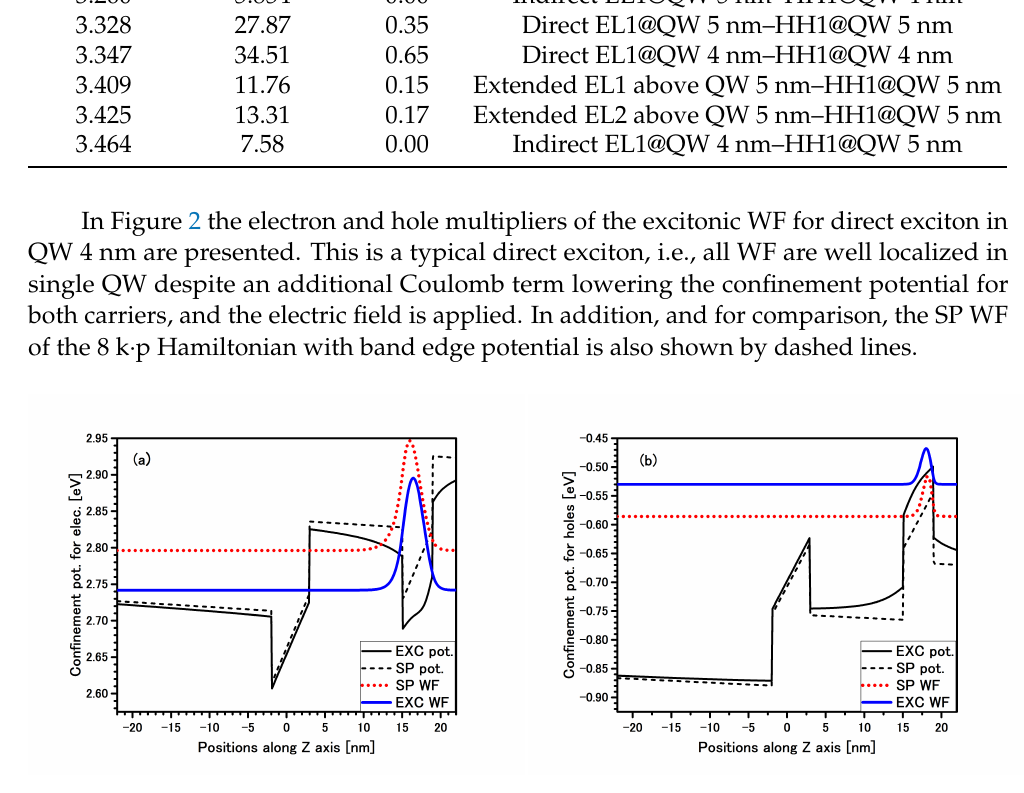
Figure 2. Band edge profile potentials (black lines) with single particle (SP) wave-function (WF) (dotted red line) and excitonic multiplier of the WF (solid blue line) for electron ( a ) and hole ( b ) for direct EL1 exciton in QW 4nm are presented in the structure #1. Solid black lines are confined potential with additional Coulomb term (Equation